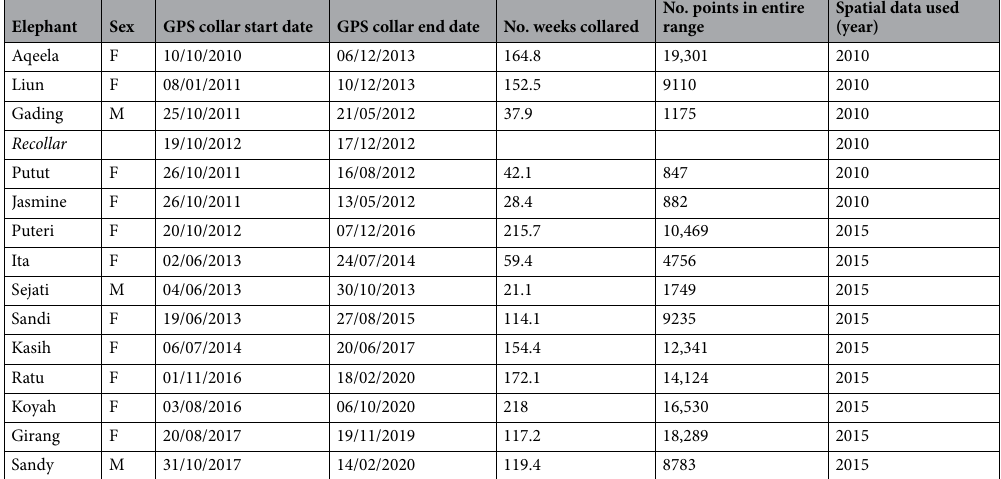
Table 1. Information on 14 collared elephants regarding their sex, start and end dates of collarings, the number of weeks with collared data, number of GPS points after data clean-up, and the year of land use spatial data used for the